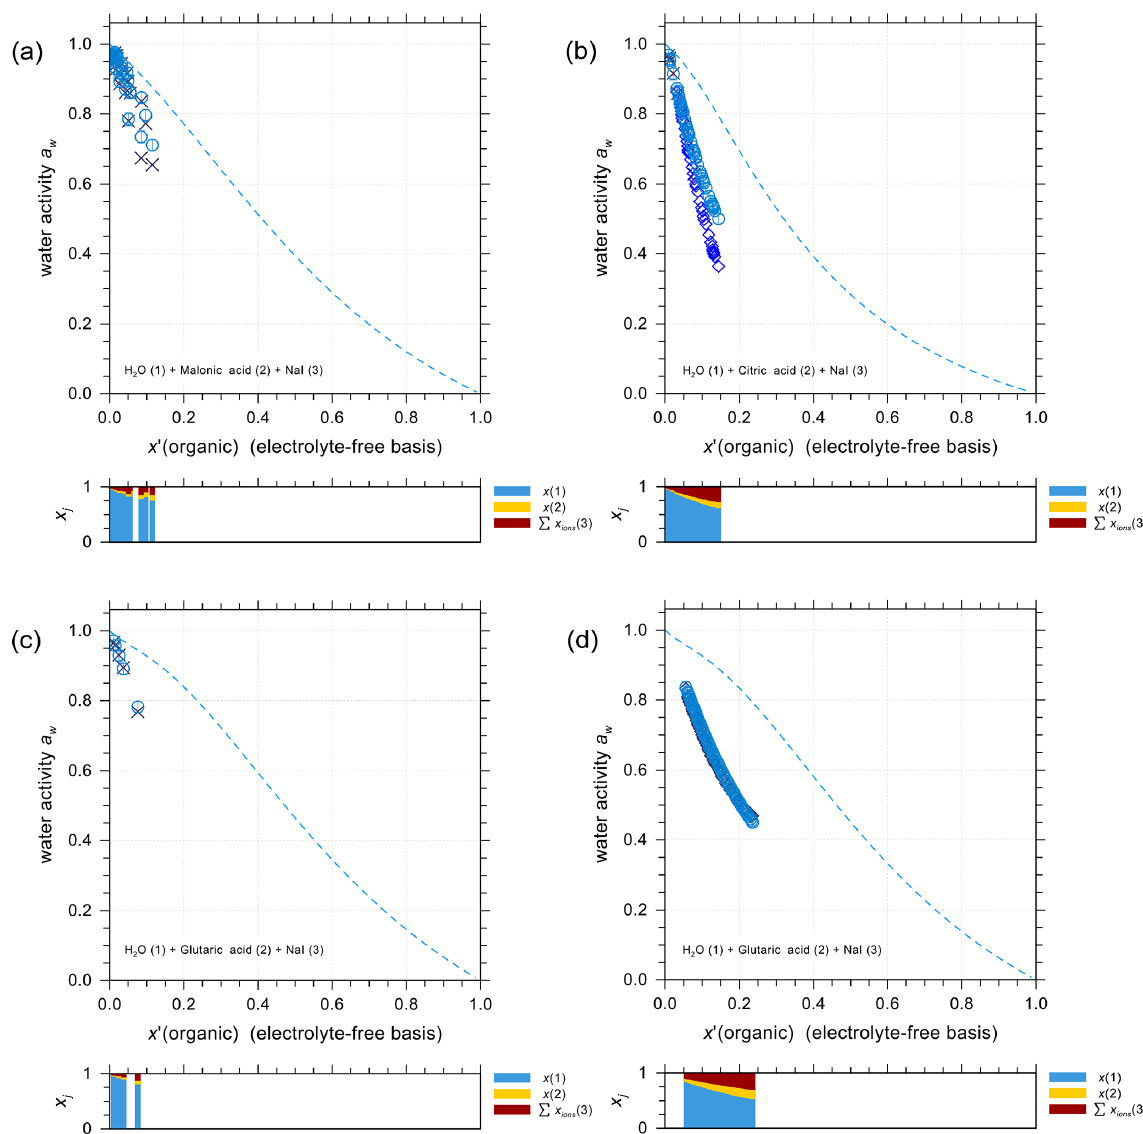
Figure 4. Water activities of NaI + water + carboxylic acid systems. Symbols: ( × ) bulk solution measurements at 298.15K; ( (cid:5) ) EDB mea- surements at various temperatures (see details in Sect. S5 in the Supplement); ( ◦ ) AIOMFAC predictions at the corresponding experimental temperatures including estimated model sensitivity shown as error bars. (a) Water (1) + malonic acid (2) + NaI (3); experiments at various mixing ratios (this study). (b) Water (1) + citric acid (2) + NaI (3); experiments at 1 : 1 mass ratio of citric acid : NaI (this study). (c, d) Wa- ter (1) + glutaric acid (2) + NaI (3); experiments at 1 : 1 mass ratio of glutaric acid : NaI (this study). The dashed curves indicate the water activities of the corresponding salt-free systems. The composition bar panels show the stacked mole fractions of the three components with respect to dissociated